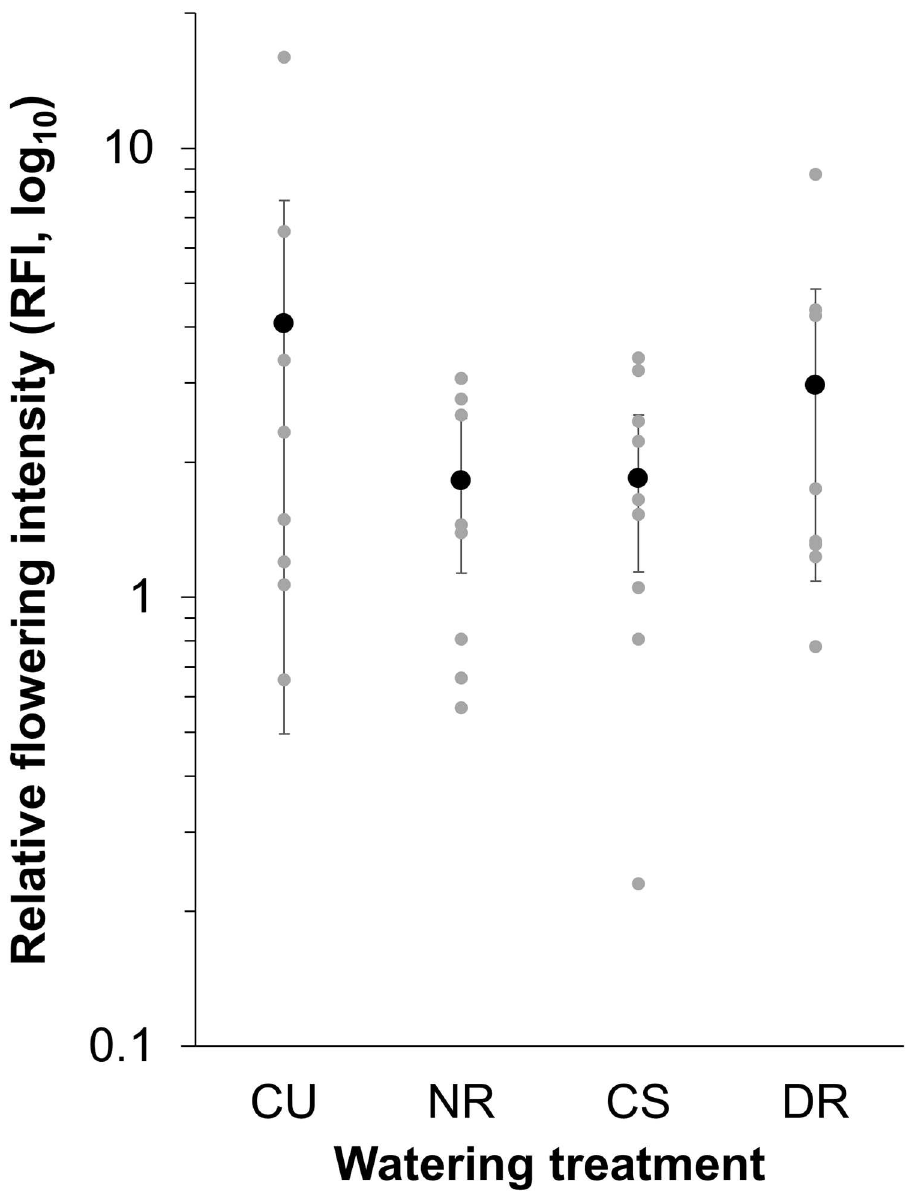
Fig 3. The effect of watering treatment (NR = No Rain, CU = Control Unsheltered, CS = Control Sheltered, DR = Double Rain) on relative flowering intensity (averagenumber of open flowers per plot across a maximum of 12 sampling dates) of Raphanus raphanistrum compared to R . sativus across nine experimental blocks (grey dots). Values above1 indicate more R . raphanistrum flowers relative to R . sativus flowers, whereas values below1 indicate more R . sativus flowers relative to R . raphanistrum flowers. Least squaresmean values ( ± 95%CI) across plots within a wateringtreatment are represented by black